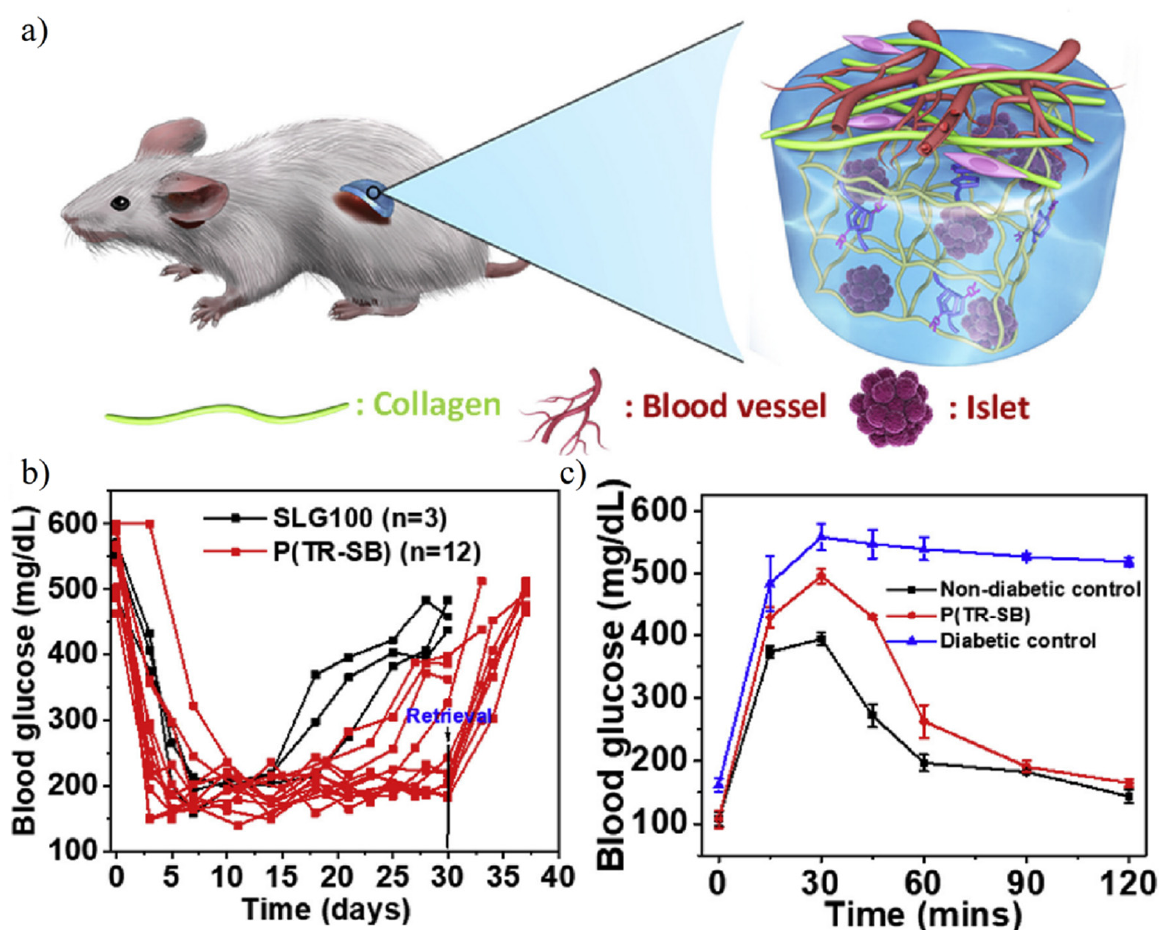
Figure 18. Islet encapsulation for diabetes treatments using triazole-zwitterionic hydrogel. ( a ) Sche- matic illustration of low fibrosis and high vascularization around islet encapsulated hydrogel. ( b ) Blood glucose concentration after 30 d of implantation. ( c ) Islet implanted mice showed normal blood glucose in 30 days and the ability to metabolize intraperitoneal glucose within 90 min was restored. Reproduced with permission from [57] . Copyright 2019 Elsevier Ltd. All rights reserved.